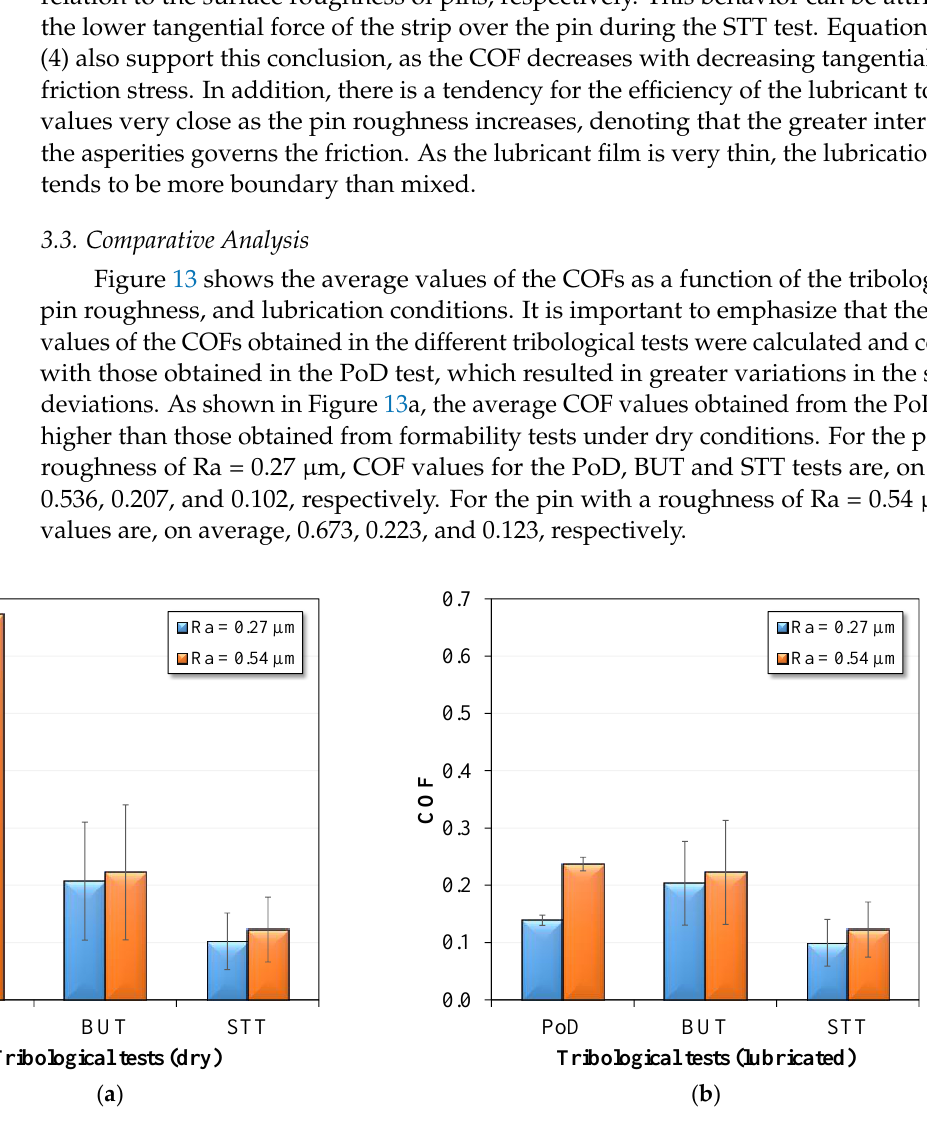
Figure 13. Average values of the COFs: ( a ) dry contact and ( b ) lubricated contact.